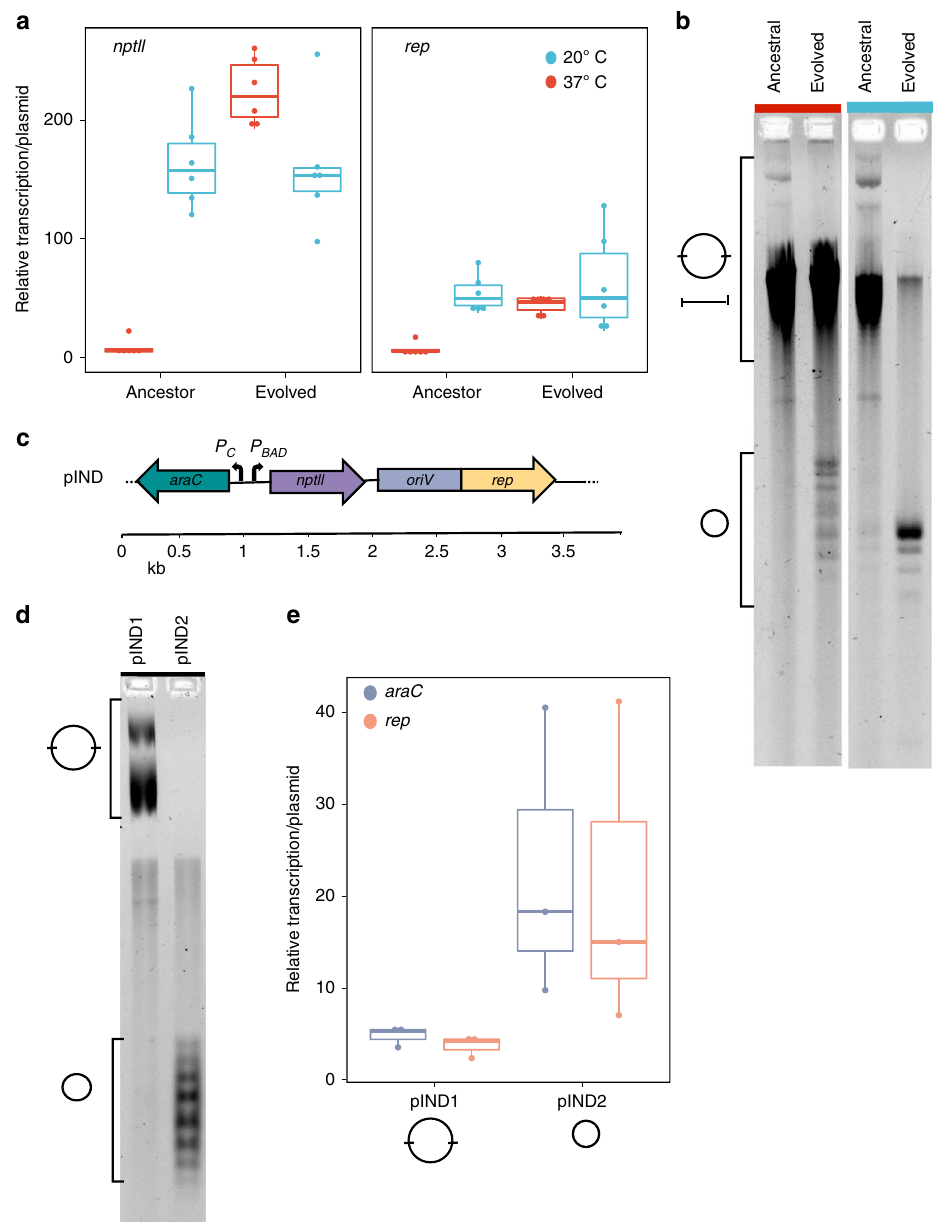
Fig. 3 pCON transcription, replication and DNA topology. a Relative transcription of plasmid genes ( nptII and rep ) in ancestral and evolved plasmids from both temperatures was calculated per plasmid (i.e., dividing by the PCN) (Supplementary Fig. 6, n = 6). The evolved plasmids at 37 °C comprise the stably inherited pCON variant from population S6. b Separation of pCON plasmid preparations by one-dimensional agarose gel electrophoresis in the presence of chloroquine (4 µ g/ml; for original gel see Supplementary Fig. 7). Chloroquine was used to resolve different topological forms of supercoiled plasmids and compare their relative motility to each other. The isolated plasmids correspond to the plasmids presented in ( a ). Symbols indicate supercoiled plasmid topoisomers of multimers (large circle) and monomers (small circle) (see Supplementary Fig. 8a for further details). We note that the low PCN of ancestral pCON plasmids at 37 °C resulted in lower plasmid yields and increased co-eluted chromosomal DNA (linear fragments, Supplementary Fig. 9a,c). c Genetic map of the plasmid pIND. d Plasmid topology of pIND plasmids (multimers and monomers, Supplementary Fig. 8b, for original see Supplementary Fig. 10) from two ancestral host populations at 37 °C (analyzed as in ( b )). e Relative transcription per plasmid of pIND-encoded genes araC and rep in the two different pIND replicates pIND1 and pIND2 at 37 °C ( n = 3). a , e The center value of the boxplots represents the median, the boxes denote the interquartile range, and the whiskers represent minimum and maximum values. Source data are provided as a Source Data fi